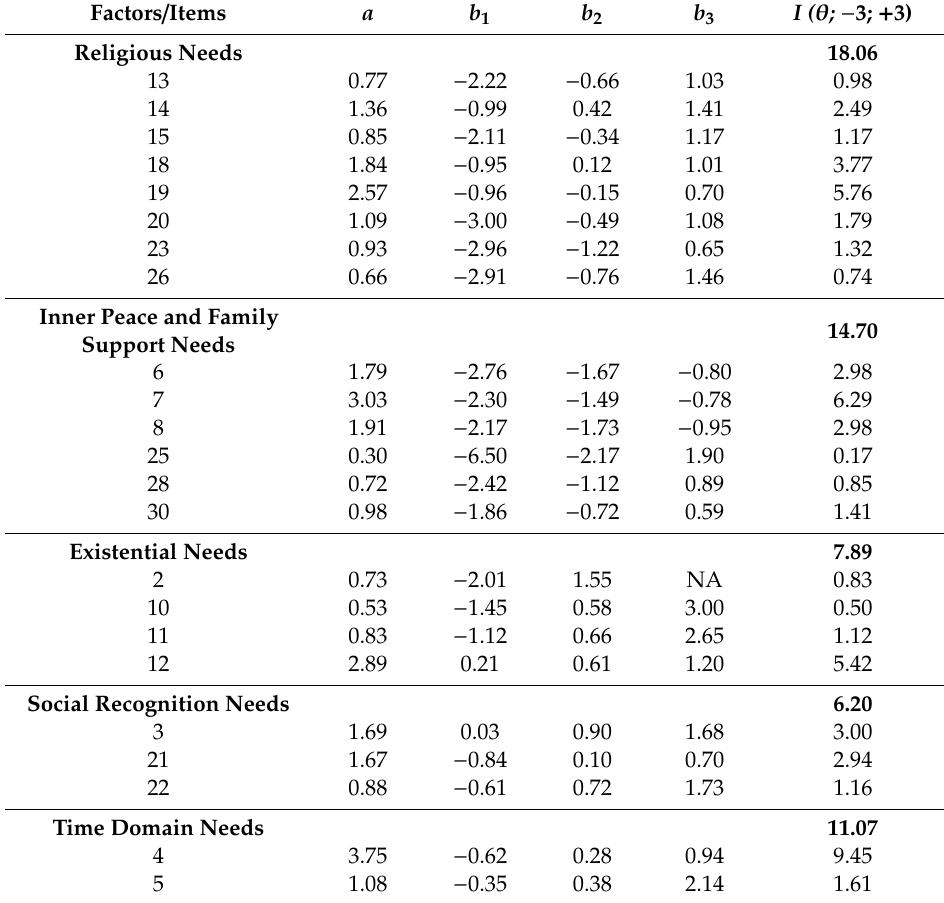
Table 1. SpNQ Item